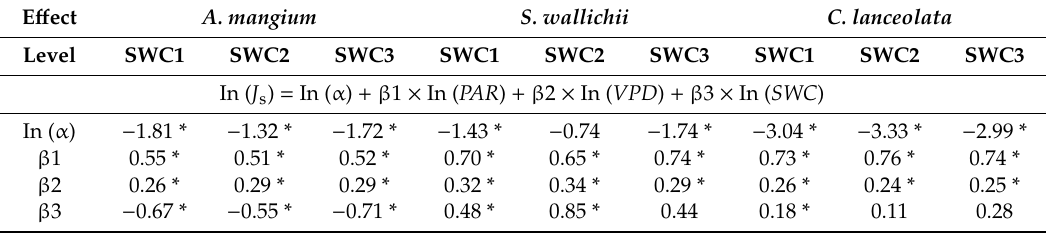
Table 6. Model estimates relating the daily mean sap flux density ( J s ) to environmental factors in di ff erent soil water content (SWC) layers.